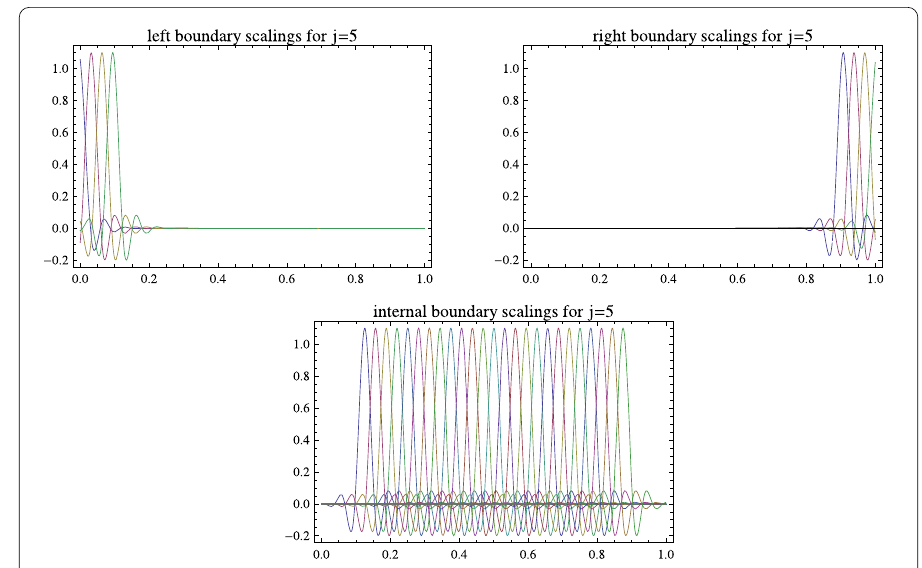
Figure 2 Family of generalized Coiflet scaling functions for N = 6 and M 1 = 7 at j =